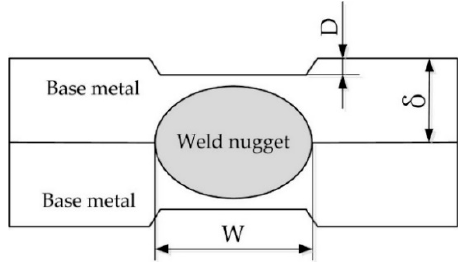
Figure 7. Schematic diagram of the main dimensions of the welded joint cross-section.